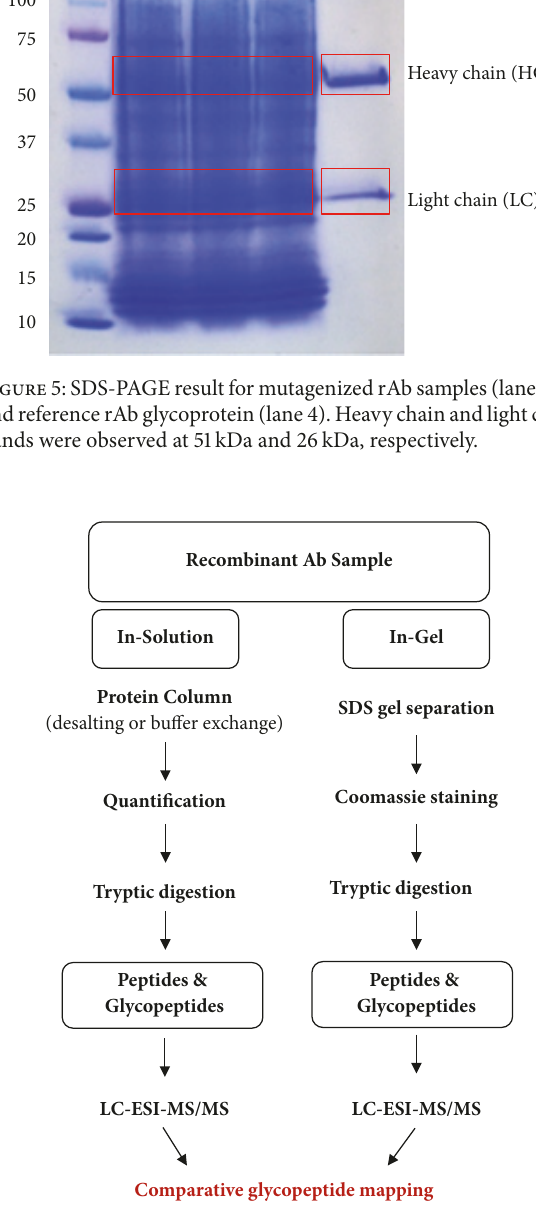
Figure 6: Comparative analysis for in-solution and in-gel rAb samples. In-solution sample is applied to a protein column and subject to tryptic digestion. In-gel sample is separated from SDS- PAGE gel and destained before tryptic digestion.